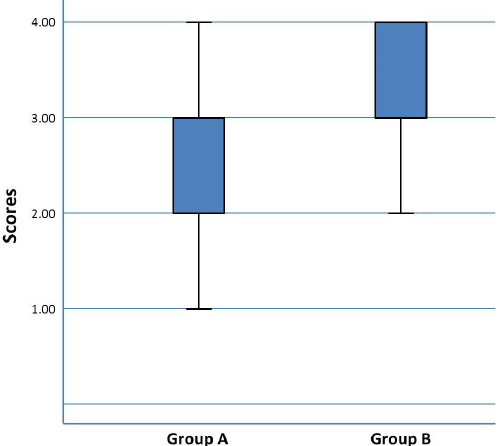
Figure 2. Qualifications of the practice of pulpotomy performed on artificial teeth (significant difference between groups; non-parametric Kruskal–Wallis distribution test, p < 0.001).